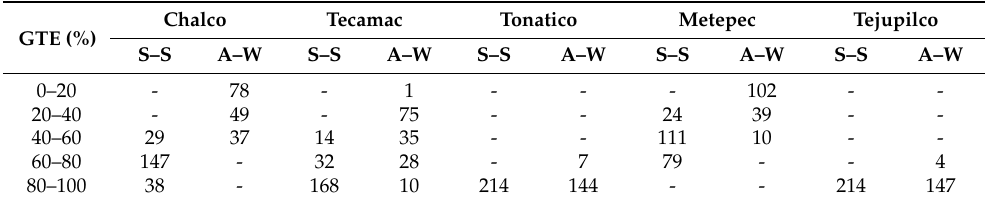
Table 2. Days inside the range of effectiveness in five regions of the state of Mexico in the cycles Spring–Summer (S-–S) and Autumn–Winter (A–W). The difference in days of the cycle is due to the temperature that slowly rises, the cost of operation in the greenhouse, and the cost of the produce. Chalco